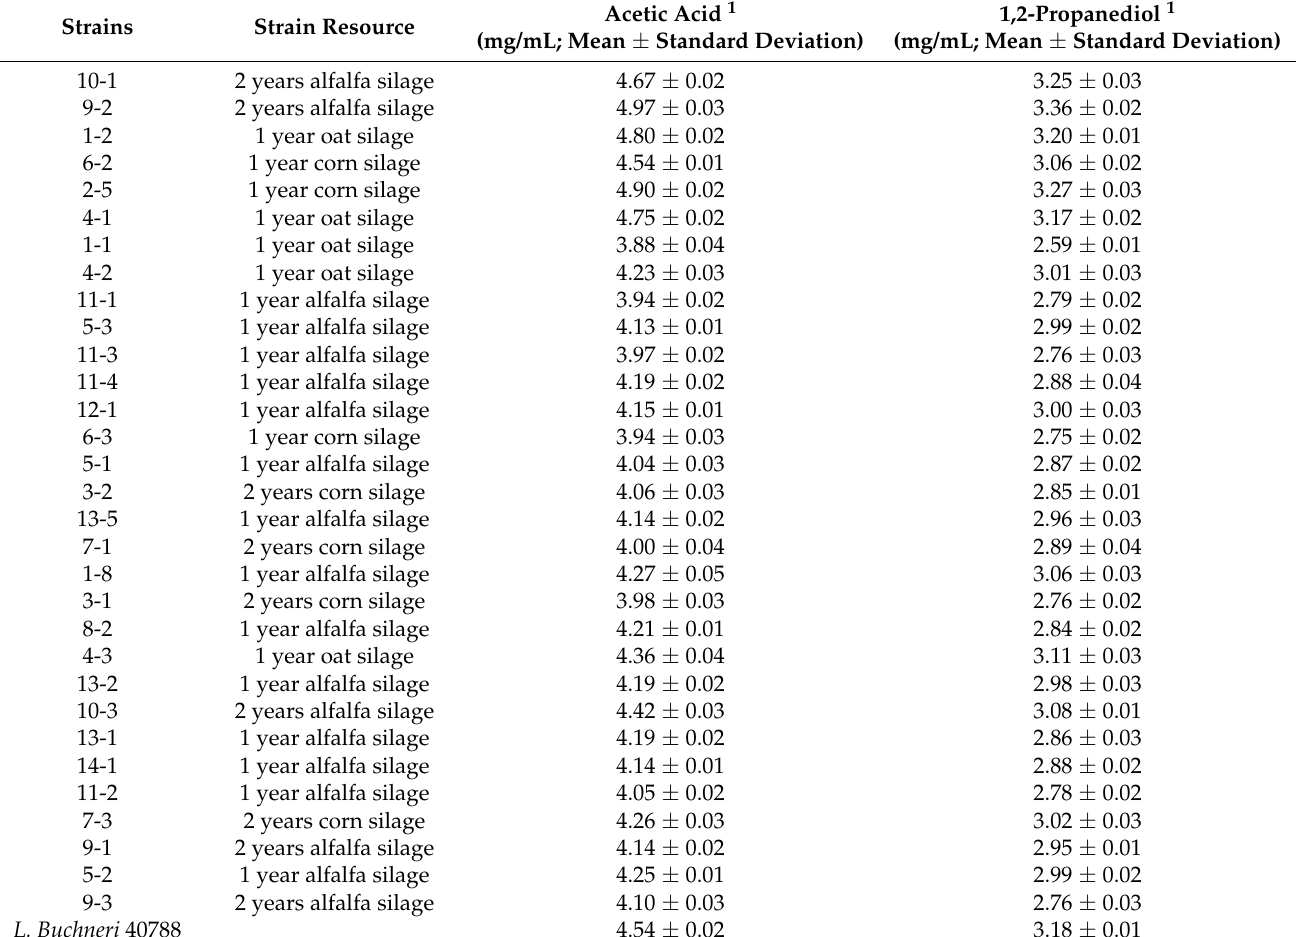
Table 2. Acetic acid and 1,2-propanediol production of L. buchneri isolates from different silages fermented for 1 or 2 years. Acetic Acid 1 Strains Strain Resource (mg/mL; Mean ± Standard